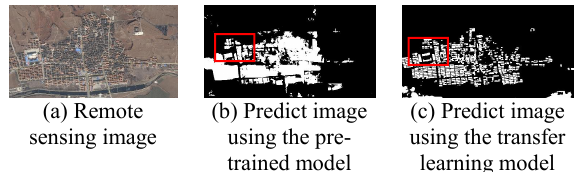
Figure 5 . Visualization of recognition results of pre-trained and transfer learning